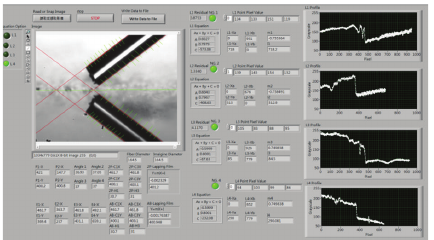
Figure 7: Photo of the front panel of the vision assistant